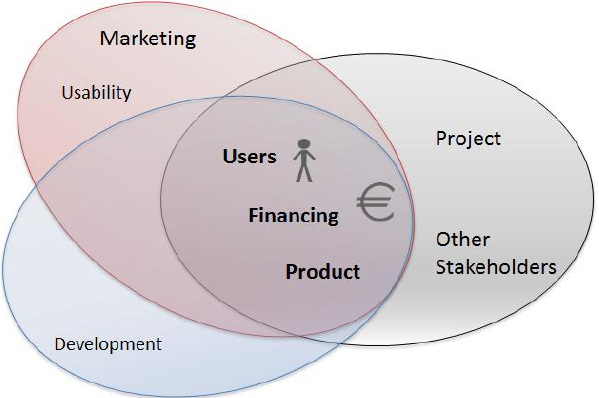
Figure 6. Overlaps in categories. Each oval contains the categories identified by one group. The categories in the middle were identified by all groups.